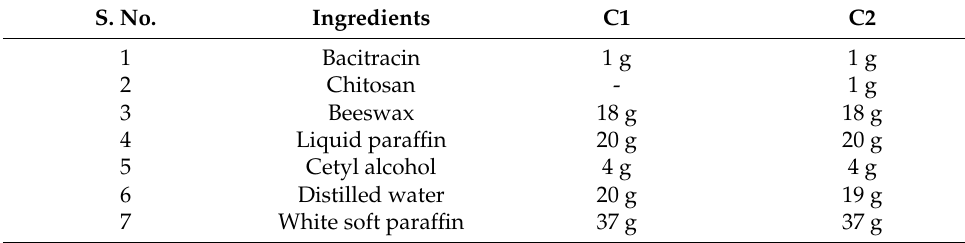
Table 1. Composition of cream ( w / w